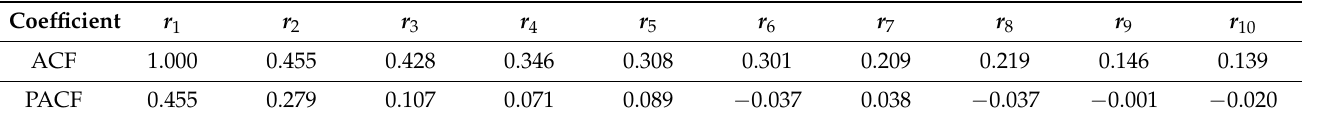
Table 1. Autocorrelation coefficients.